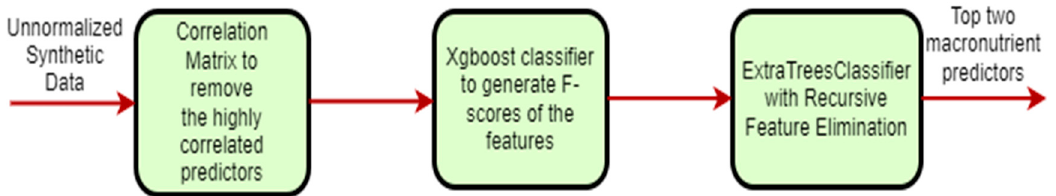
Figure 2. Feature selection pipeline for choice of appropriate nutrient predictors.